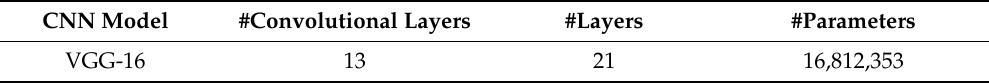
Table 2. Basic parameters of the applied